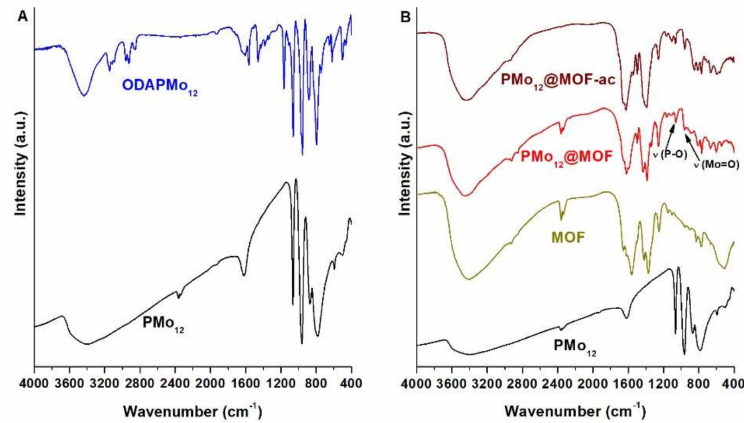
Figure 1. FT-IR spectra of ( A ) the homogeneous catalysts and ( B ) the NH 2 -MIL-101(Cr) (MOF) support and the corresponding PMo 12 @MOF composite before and after catalysis